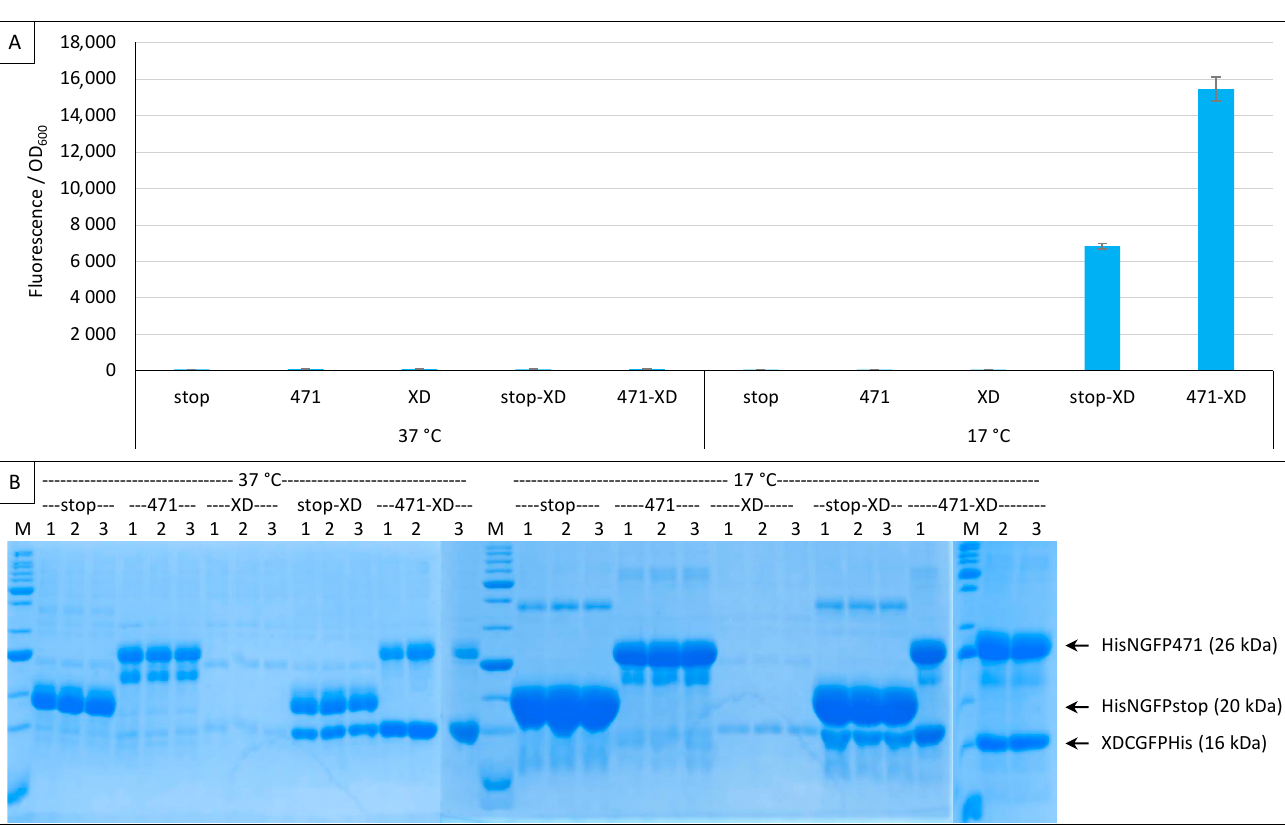
Figure 9. XD-CGFP is degraded when expressed alone . Split-GFP reassembly assay results as obtained with different combinations of plasmids and with the negative (stop) and positive (471) controls of the 471/XD interaction with the fr GFP reporter at 37 °C and 17 °C. Only pMRBad encoding XD-CfrGFP-His was used. ( A ) Fluorescence to OD 600 ratios. All experimental points were induced with both arabinose and IPTG. Fusion proteins (stop, 471, XD) and fusion protein combinations (stop-XD, 471-XD) are indicated on the x-axis. ( B ) SDS-PAGE analysis of the expression of the NGFP and CGFP fusions. Triplicates were loaded individually (1, 2, 3). M, molecular size markers (200, 150, 100, 85, 70, 60, 50, 40, 30, 25, 20, 15, 10 kDa).